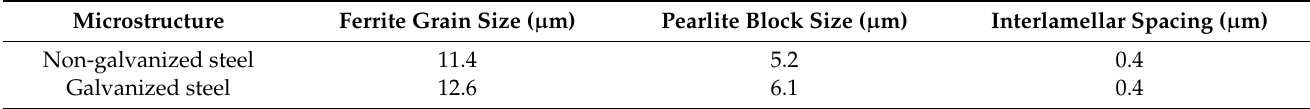
Figure 3. SEM (BSE) image of the different phases of the galvanizing layer. 3.2. Mechanical Properties The results of tensile tests revealed that the non-galvanized steel had an upper yield strength ( (cid:2026) (cid:3022)(cid:3026)(cid:3020) ) of 340 MPa, a lower yield strength ( (cid:2026) (cid:3013)(cid:3026)(cid:3020) ) of 297 MPa, an ultimate tensile strength ( (cid:2026) (cid:3021)(cid:3020) ) of 432 MPa, and an elongation of 32%. The galvanized steel had a yield strength ( (cid:2026) (cid:3026)(cid:3020) ) of 280 MPa with no lower yield point, an ultimate tensile strength ( (cid:2026) (cid:3021)(cid:3020) ) of 404 MPa, and an elongation of 36% (Figure 4). The hardness test results of the substrates revealed an average hardness value of 175.2 Hv for non-galvanized steel and 168.4 Hv for galvanized steel. The slight difference in tensile properties and Vickers hardness values between non-galvanized and galvanized steel agreed with their microstructures. The Vickers’ hardness values measured across the galvanizing layer from the eta phase to the